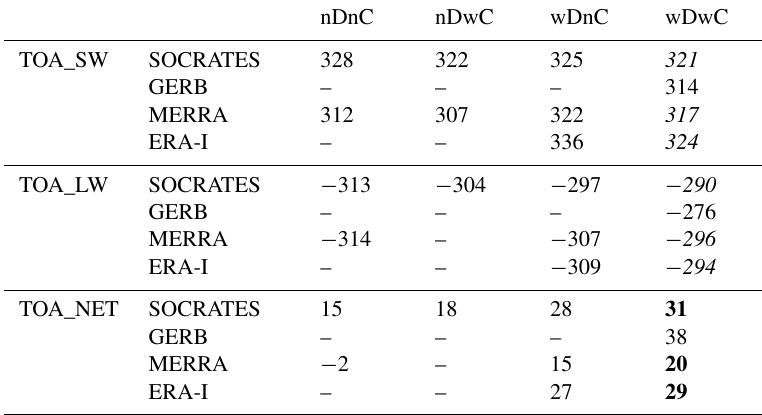
Table 2. Mean 8–30 June 2011 TOA radiative flux at BBM (definitions of acronyms of model experiments are given in Table 1). Values are in Wm − 2 . The sign convention is that downward flux is considered positive while upward flux is negative. In the sixth column, italic (bold) fonts indicate model results overestimated (underestimated) compared with observation.